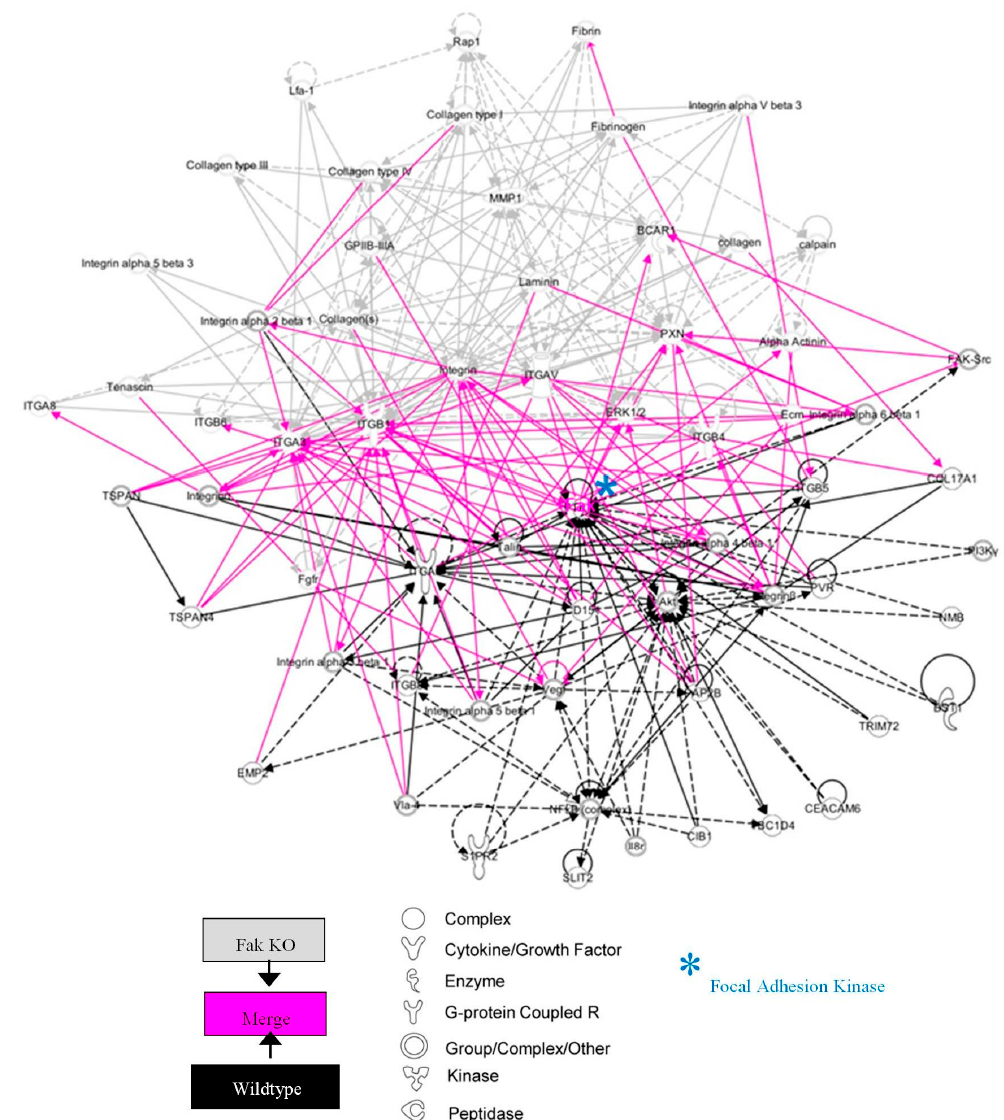
Figure 2. FAK-deleted keratinocytes demonstrate alterations in key mechanotransduction and collagen signaling pathways. The top scoring Ingenuity Pathway Analysis (IPA)-constructed transcriptome network generated from genes significantly up-regulated (grey) and down-regulated (black) in FAK-deleted keratinocytes compared to WT cells were merged using IPA’s Ingenuity Knowledge Base, creating a super-network centered on the FAK-AKT-ERK axis. Direct relationships are indicated by solid lines, and dashed lines represent indirect relationships. Known relationships among molecules across the original two networks are represented in magenta. * denotes FAK (PTK2).